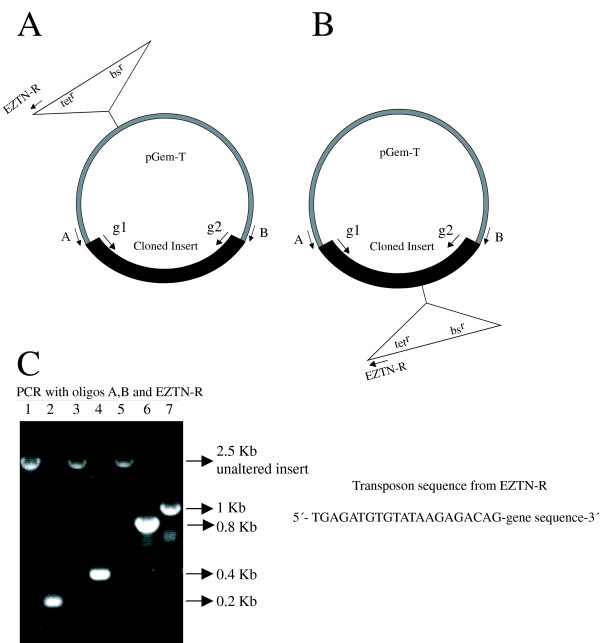
Optimizing the selection of the transposable cassette insertion into the target gene. A model of a cloned gene into the vector pGEM-t is shown in panels A and B. Two possible insertion events of the EZTN transposon are depicted: one in the vector (A) and the other in the cloned gene (B). The oligonucleotides used for cloning and analysis are shown as arrows. Panel C shows a PCR analysis of bacterial isolates after in vitro transposition. Oligonucleotides A, B and EZTN-R were used to estimate the approximate location of the transposon insertion. Lanes 1,3 and 5 correspond to insertion events probably located in the vector, as shown in the diagram of panel A. In this case, a 2.5 Kb insert corresponding to the size of the cloned gene is expected. Lanes 2,4,6 and 7 indicate insertion events in different points along the cloned gene, a situation illustrated in panel B. Panel C (right side) also shows the expected sequence obtained from the PCR products of lanes 2,4,6 and 7 by using the EZTN-R primer. The specific gene sequence located after the end of the transposon will indicate the precise location of the insertion as well as the orientation of the transposon.